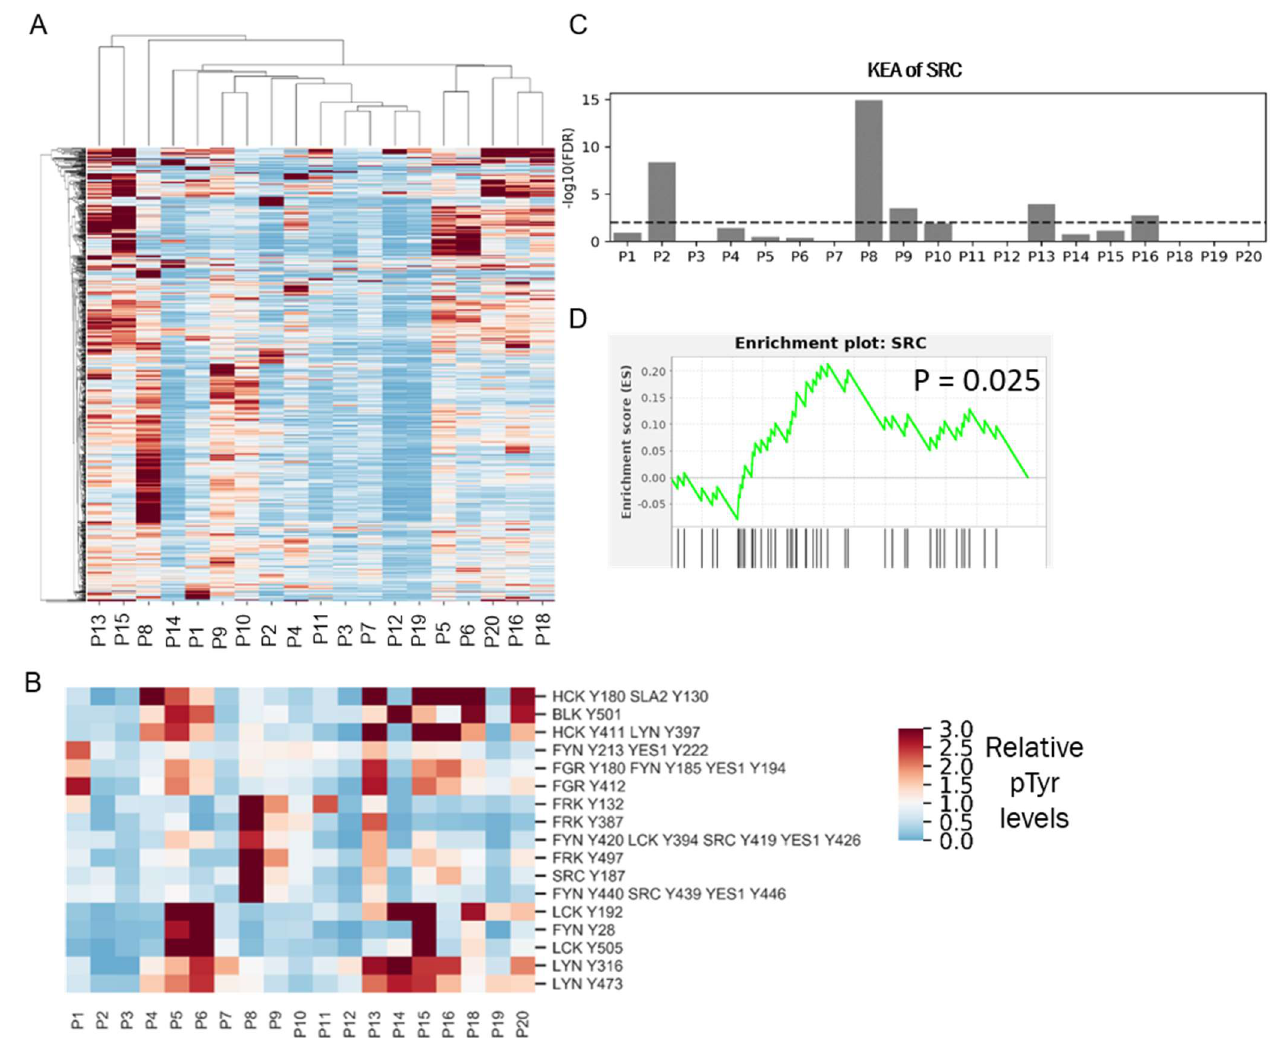
Figure 6. Phosphotyrosine analysis of clinical specimens. ( A ) HCA heatmap of pTyr peptides identified and quantified in 19 patient tumors. Quantified levels presented as the fold change relative to the mean. ( B ) Heatmap of pTyr sites belonging to SFKs. ( C ) Enrichment of Src in the KEA analysis of pTyr sites that were highly phosphorylated in respective patient tumors. Dashed line depicts FDR q-value = 0.01. ( D ) Enrichment plot of SRC substrates in P8 tumor. pTyr sites were rank-ordered and running enrichment score was calculated with the GSEA pre-ranked